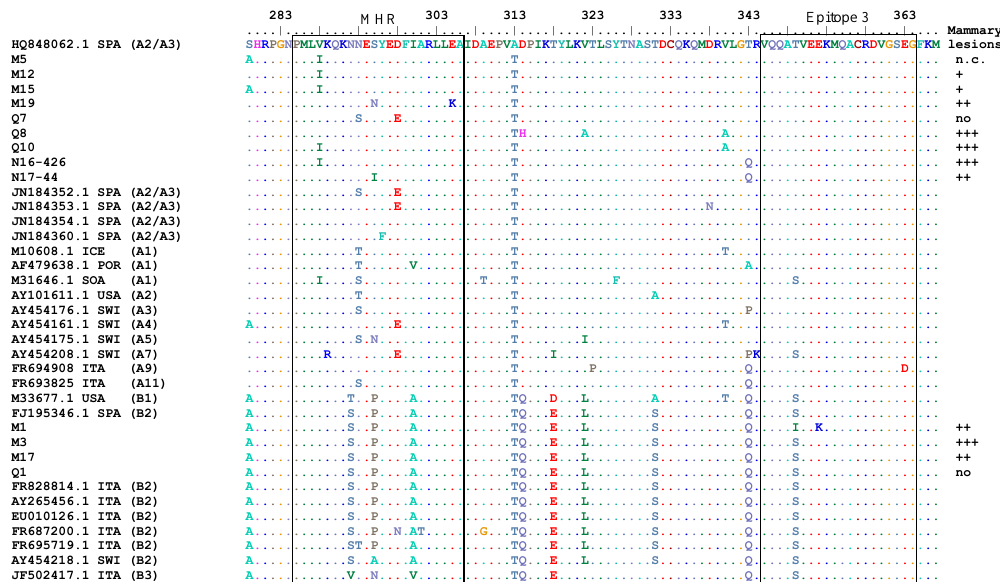
Figure 4. Alignment (MUSCLE) of deduced amino acid sequences of partial gag -p25 of the SRLV sequences obtained and of some SRLV reference strains; ( a ) positions from 209 to 278, ( b ) posiions from 279 to 368. Two immuno-dominant epitopes of this capsid protein, the GG motif, and the Major Homology Region (MHR) are within squares. The score of mammary lesion of each sample is reported. Legend: ( · ) homology, ( − ) deletion, (+++) severe lesions, (++) moderate lesions, (+) minimal